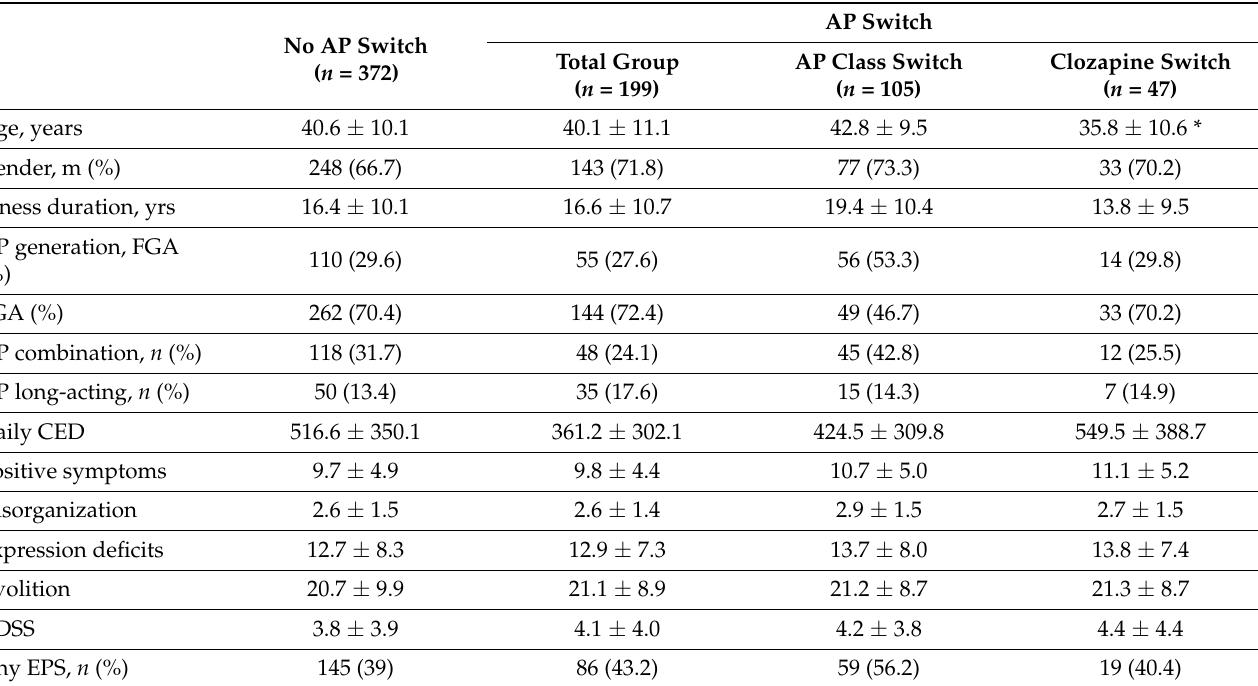
Table 1. Demographic and clinical characteristics of study participants at baseline according to the occurrence of antipsychotic switch. AP, antipsychotics; CDSS, Calgary Depression Scale for Schizophrenia; CED, chlorpromazine equivalent doses; EPS, extrapyramidal symptoms; FGA, first- generation antipsychotics; SGA, second-generation